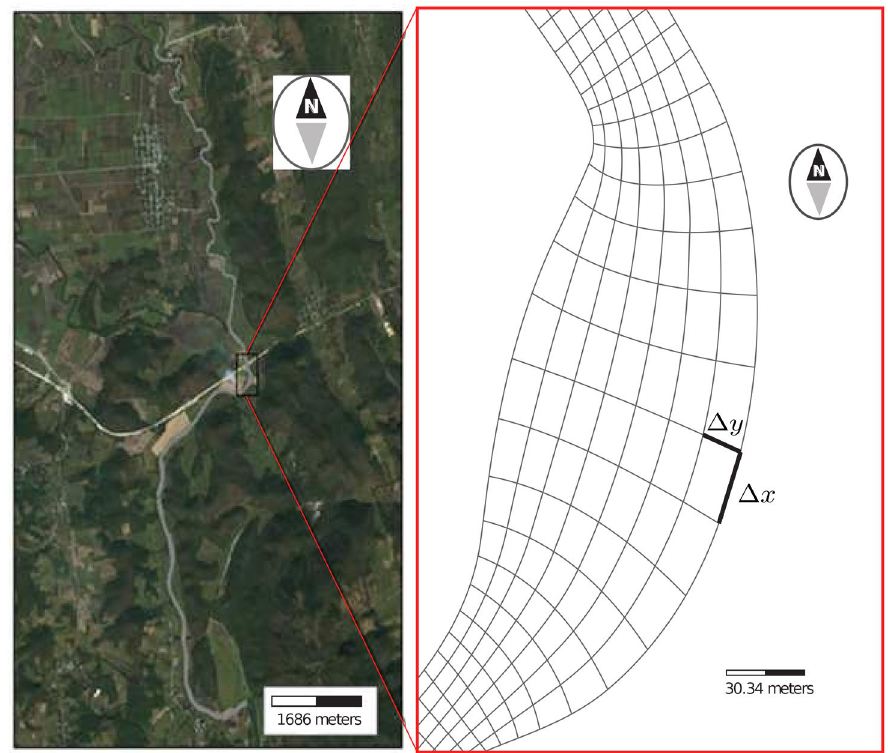
Figure 3. Curvilinear numerical grid generated. This figure was generated using the post-processing visualization tool of the EFDC Explorer (https:// www. eemod eling system.